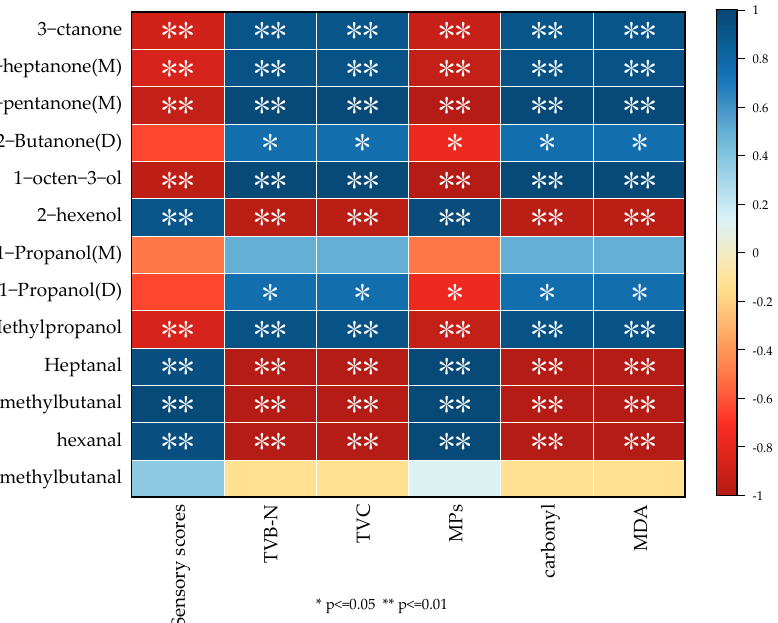
Figure 8. Correlation analysis between several VOCs and physicochemical properties of pike eels.